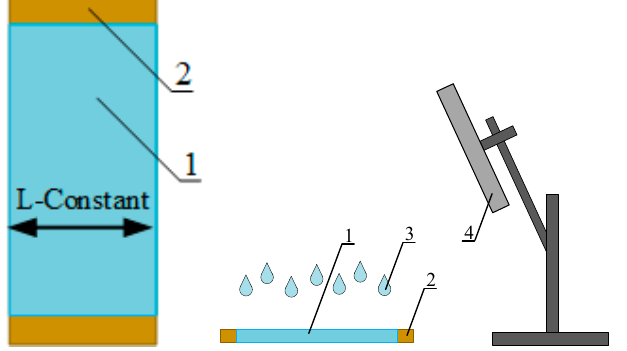
Figure 1. Schematics of model film samples preparation for DSC analysis. 1—film, 2—mandrel for fixing the film size along the shrinkage direction, 3—solvent, 4—air flow stimulator, 4—vacuum evacuation (not shown).